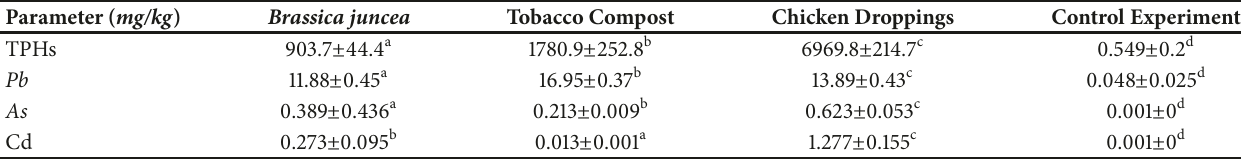
Table 4: Comparison of Brassica juncea , tobacco compost, and chicken